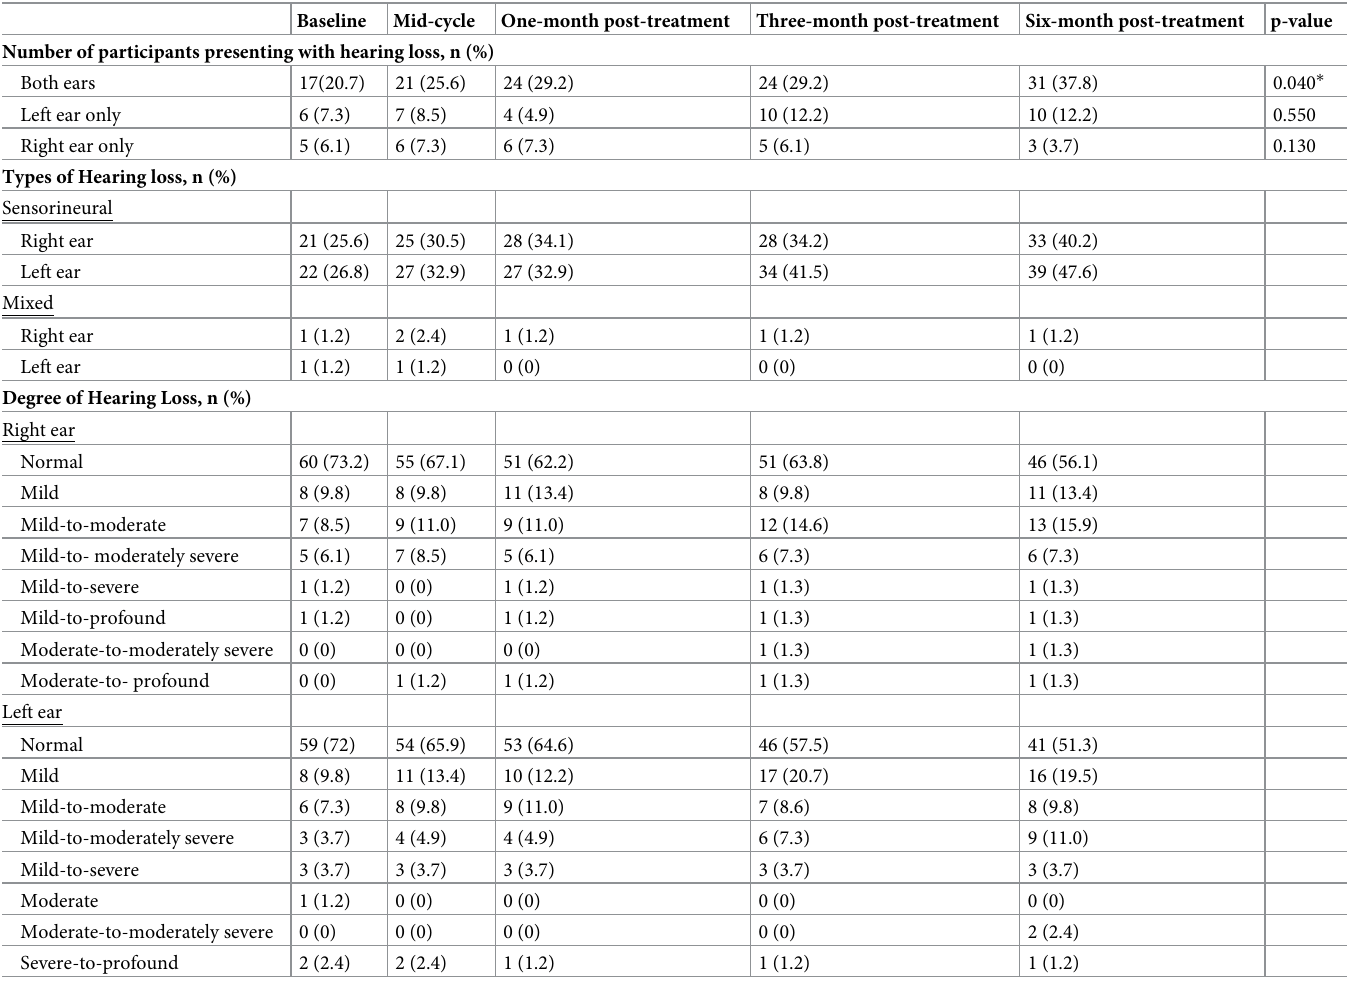
Table 3. Characteristics of hearing loss as indicated by pure tone